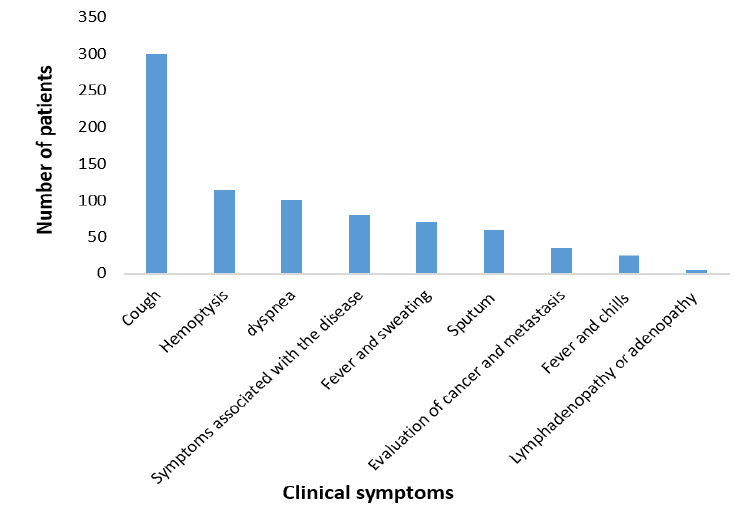
Figure 1. Clinical symptoms of the patients at referral time